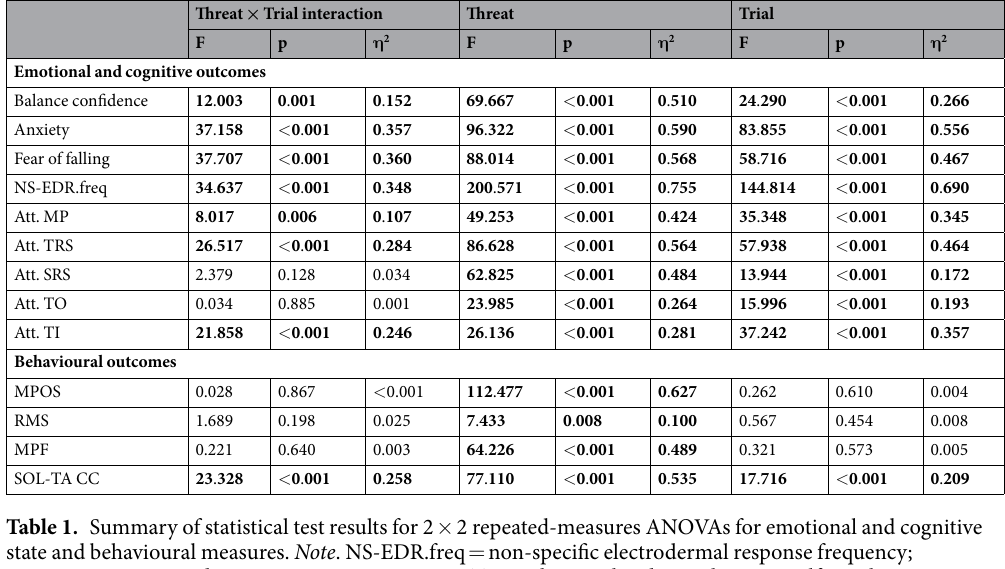
Table 1. Summary of statistical test results for 2 × 2 repeated-measures ANOVAs for emotional and cognitive state and behavioural measures. Note . NS-EDR.freq = non-specific electrodermal response frequency; Att. = attention toward; MP = movement processes; TRS = threat-related stimuli; SRS = self-regulatory strategies; TO = task objectives; TI = task-irrelevant information; MPOS = mean position of centre of pressure; RMS = root mean square of centre of pressure; MPF = mean power frequency of centre of pressure; SOL-TA CC = soleus-tibialis anterior co-contraction. Significant effects are bolded.